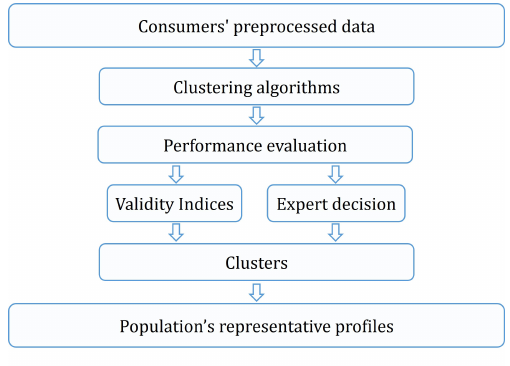
Figure 3. Outline of the clustering